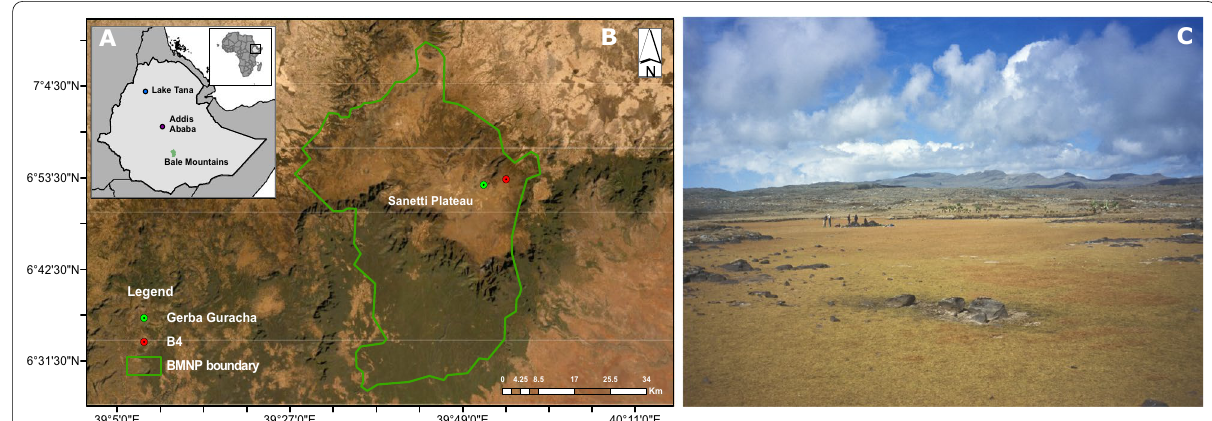
Fig. 1 Location map of the study area. A Location of Ethiopia in Africa and regional location of the Bale Mountains National Park (BMNP) and Lake Tana. B Location of B4 depression on the Sanetti Plateau and location of Lake Garba Guracha. C Photo of B4